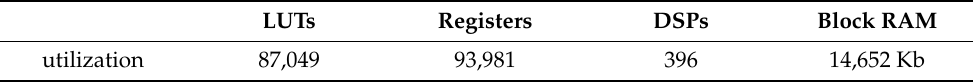
Figure 7. Experimental setup. Table 2. Resource utilization.